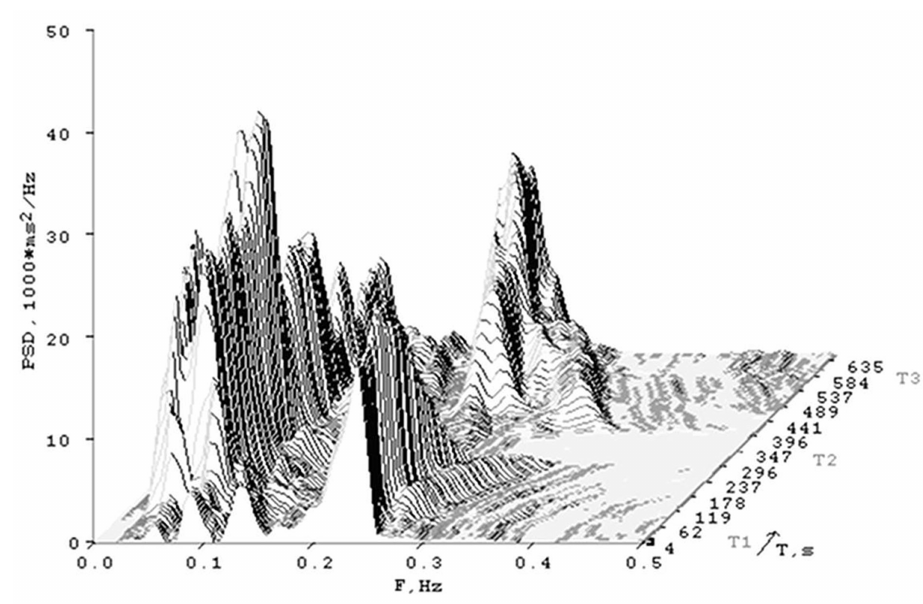
Fig. 1. Spectral analysis of heart rate variability in a young healthy subject during the supine–stand- ing–supine